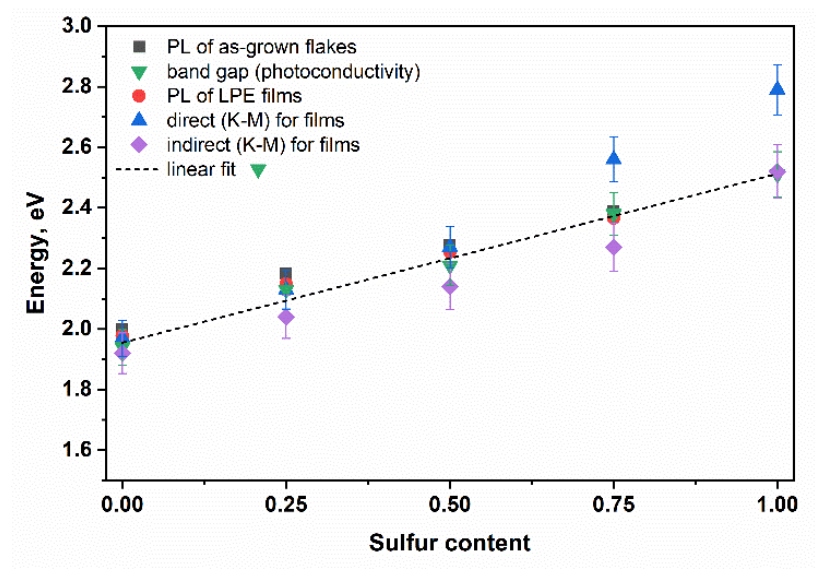
Figure 12. Dependence of band gap values of GaSe 1 − x S x determined by different methods on sulfur content.